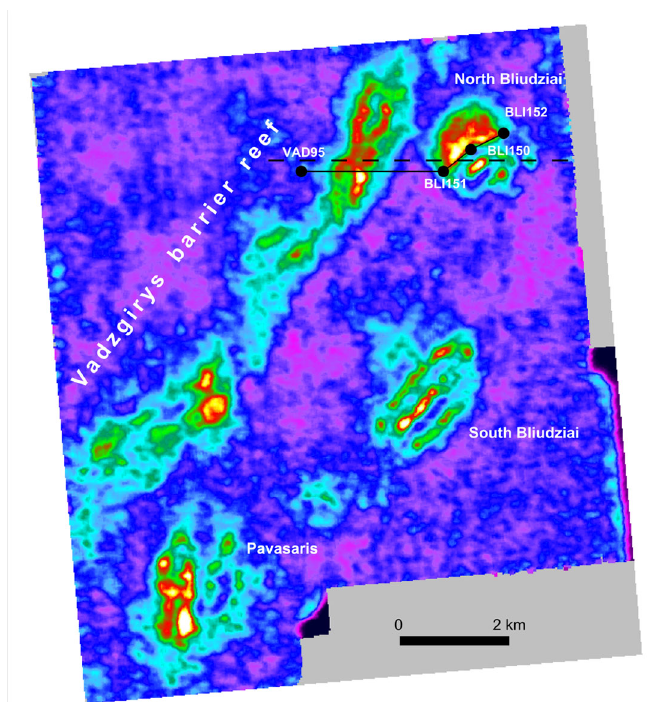
Fig. 4. Root-mean-square attribute map calculated for 135(cid:150)180 m (RMS1) from the top of the Silurian. The 3D seismic cross line on the map is shown as a dashed line. The black dots connecting the solid line show the V shl cross section. The colour scale denotes relative seismic reflections strength. Well abbreviations: VAD95, Vadzgirys 95;